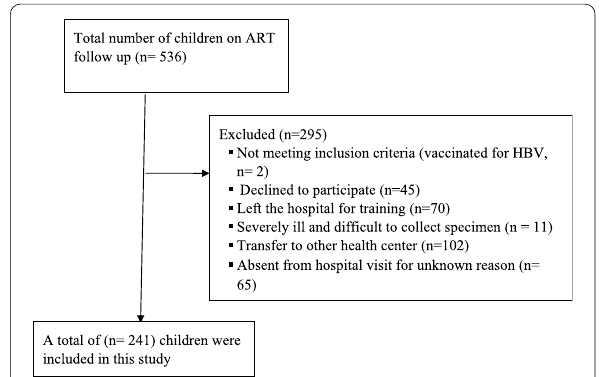
Fig. 1 The flow diagram of the inclusion process of study